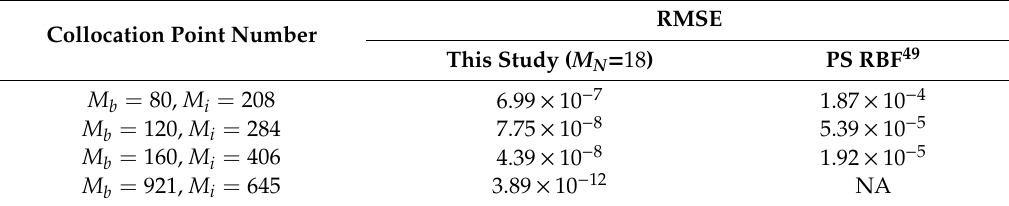
Table 3. Results comparison between this study and the PS RBF.